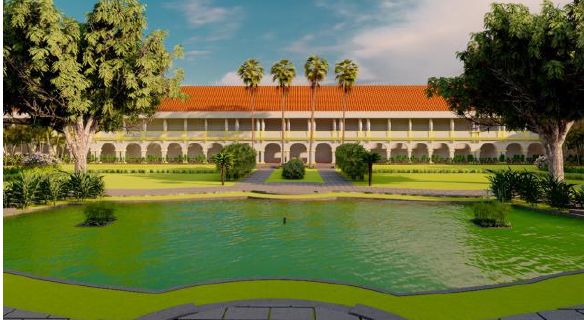
Figure 10. Three-dimensional modeling of the central garden of the Central Pavilion